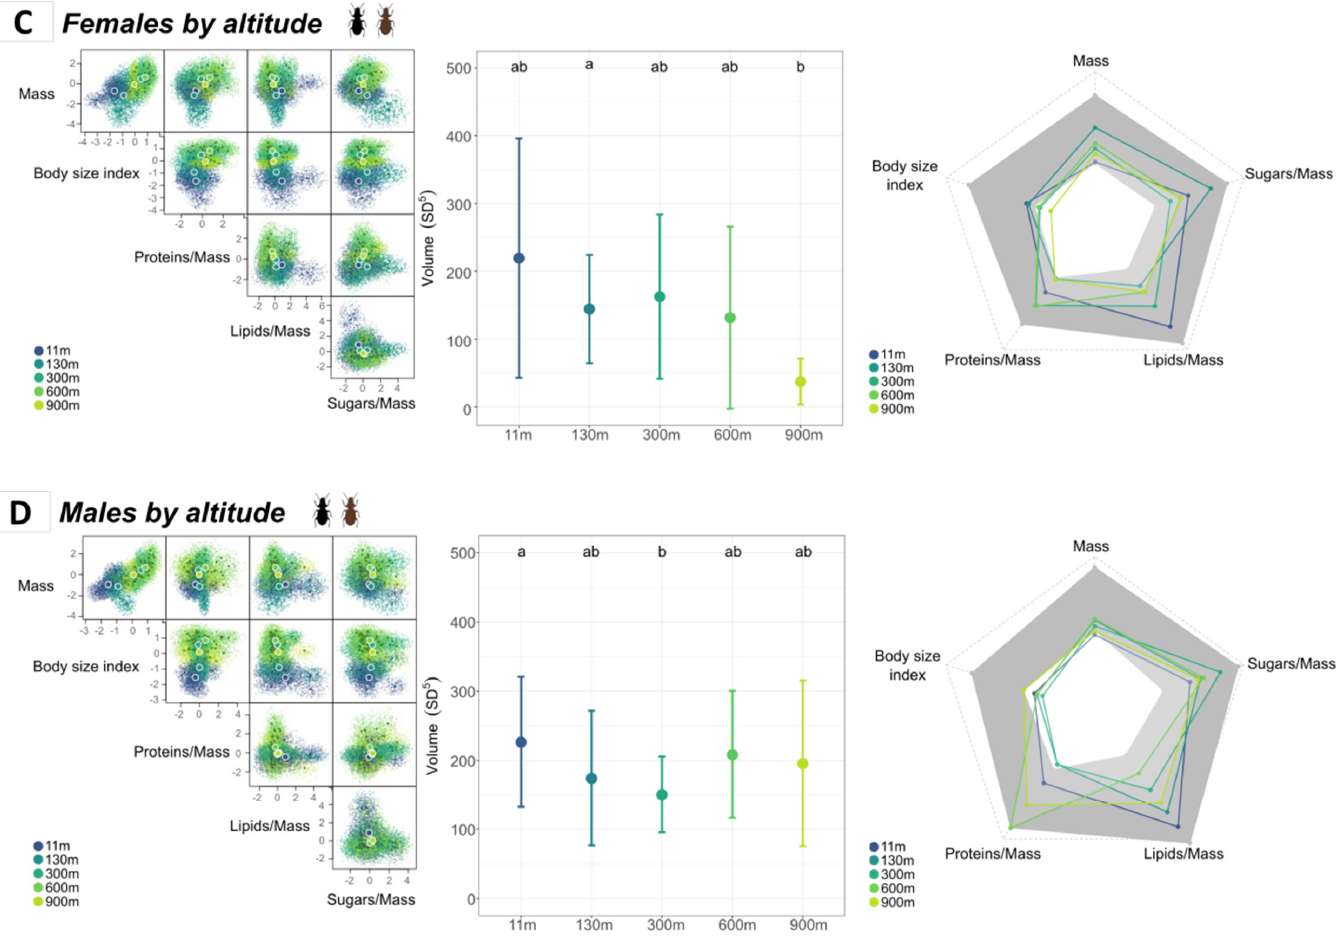
Figure 5. Hypervolumes based on five functional traits over five altitude levels at the species level: ( A )—Effect of altitude on the light morphotype; ( B )—Effect of altitude on the dark morphotype; ( C )—Effect of altitude for females; ( D )—Effect of altitude for males. The figures in the left panel represent the probabilistic hypervolume clouds. Colors correspond to levels of the explanatory variables (e.g., altitude, morphotype, and/or sex), and larger points are the centroids of